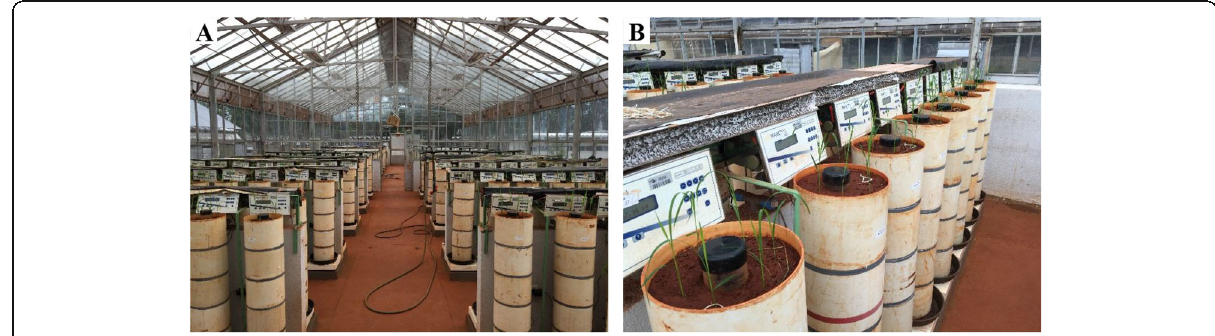
Fig. 1 Experiment in greenhouse. View of SITIS phenotyping platform ( a ), view of the PVC pipes containing the soil, the transparent acrylic tube in the middle and the rice seedlings around it, before thinning to three plants ( b